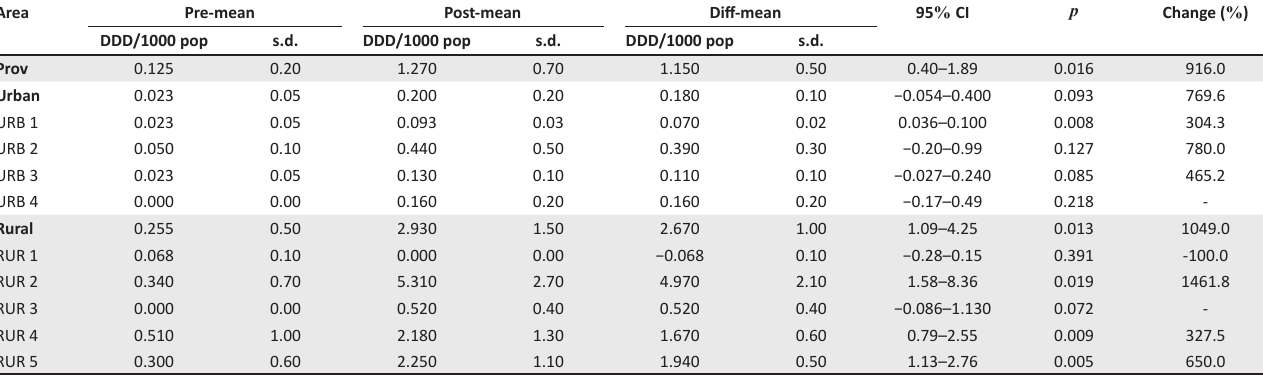
TABLE 3: Mean consumption per quarter and change in the consumption of levetiracetam pre- and post-policy implementation, 2018–2020. Area